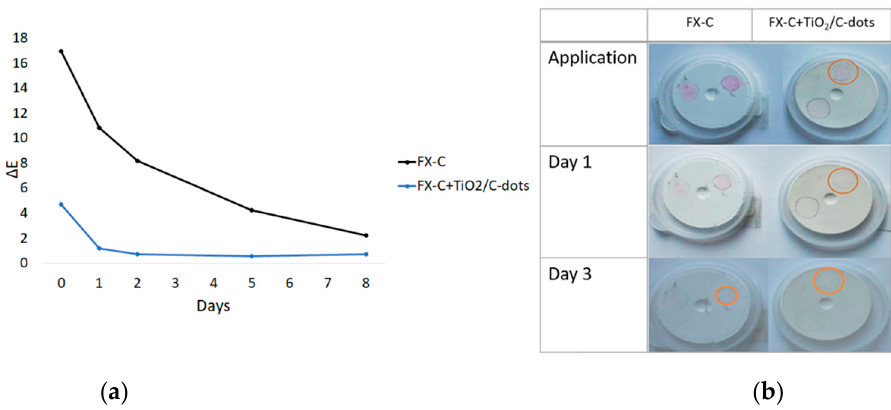
Figure 14. ( a ) Variation graph of factor Δ E as a function of time. ( b ) Visual evaluation of the samples over time.